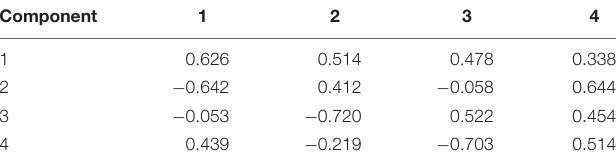
TABLE 5 | Component transformation